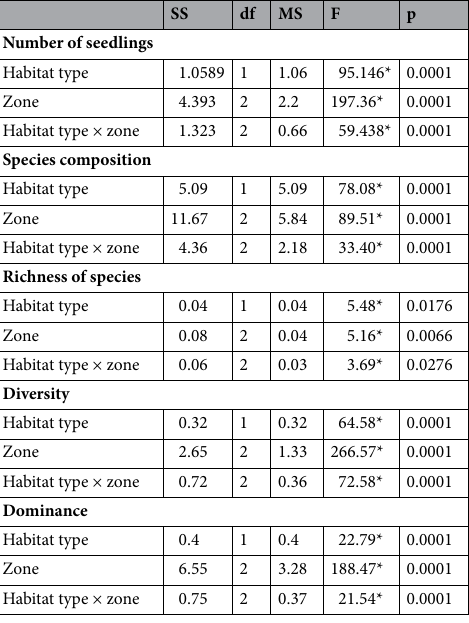
Table 3. Results of two-way PERMANOVA for the soil seed bank; differences in the number of seedlings and diversity indexes for zones and habitat types. SS sums of squares, df number of degrees of freedom, MS mean square, F value F, p value p; *statistically significant result (p < 0.05).